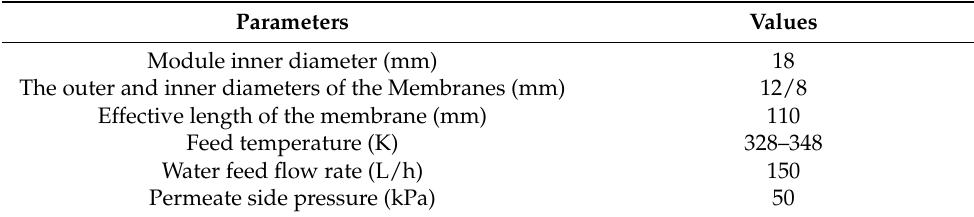
Table 3. Membrane contactor parameters and operational variables.